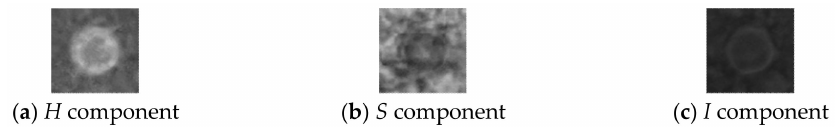
Figure 5. HSI color component diagrams.